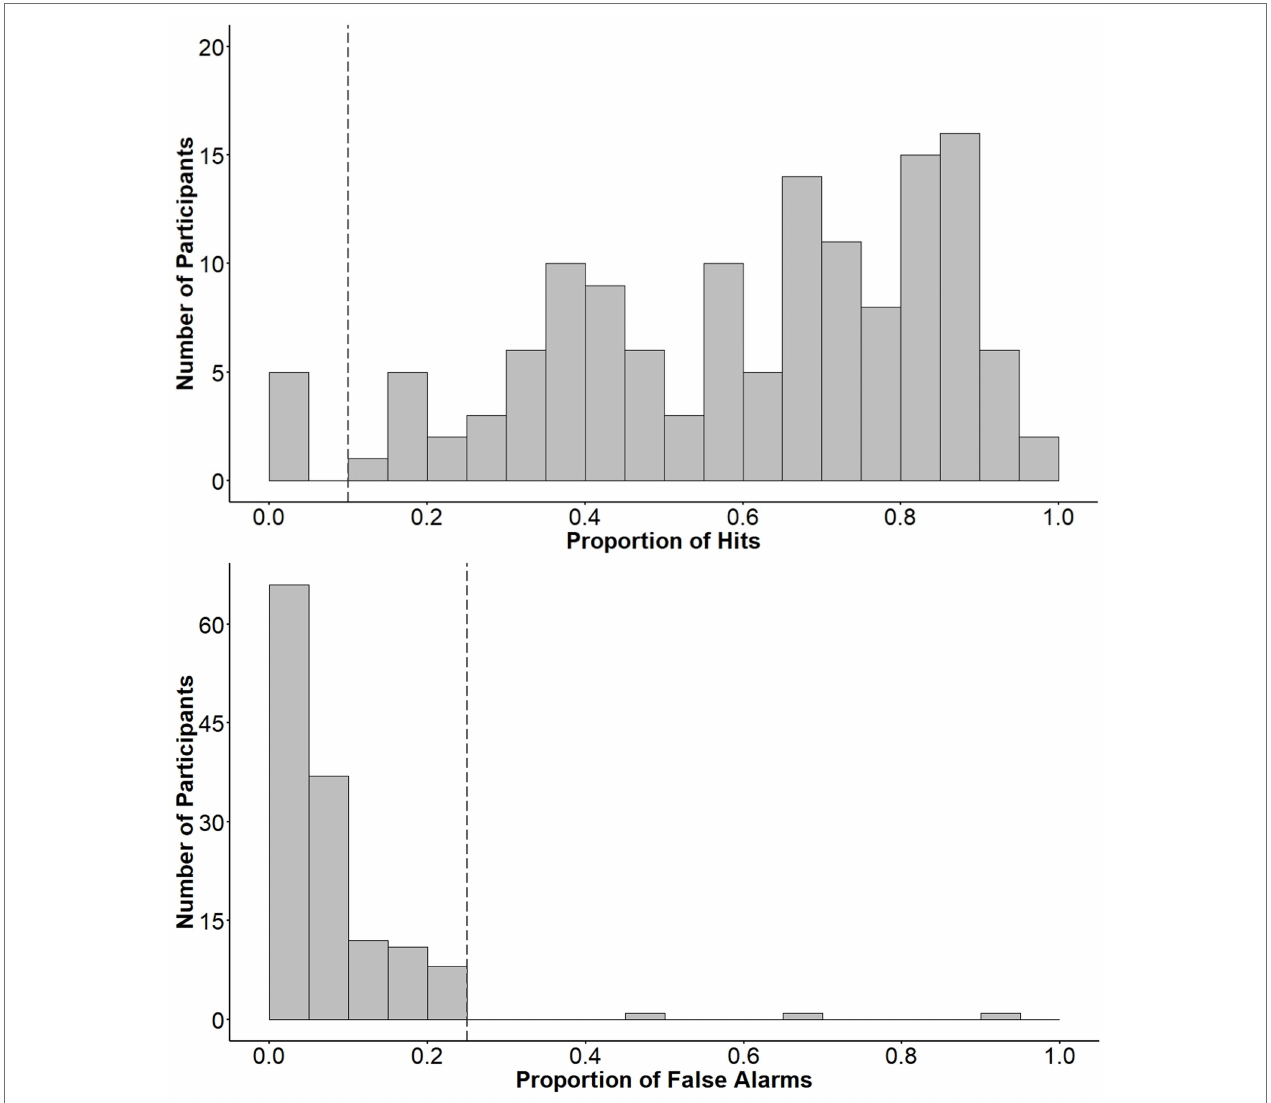
FIGURE 2 | Histograms depicting participants’ proportions of hits ( top ) and false alarms ( bottom ). Vertical dashed lines mark the cut-off points for data